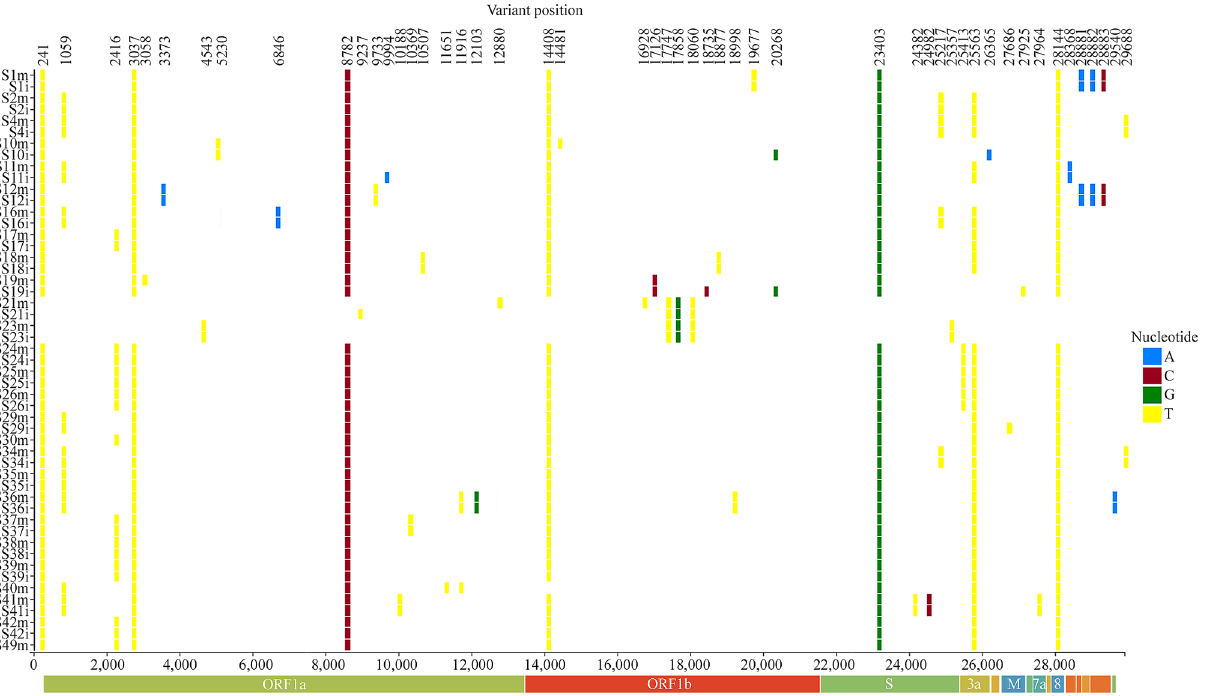
Figure 1. Distribution of polymorphisms in 27 SARS-CoV-2 genome sequences isolated from the early cases of COVID-19 in eastern Ontario. Viral genome sequencing identified forty-six polymorphic sites in twenty-seven viral genomes. S_m refers to the sample sequenced on the MinION and S_i refers to the sample sequenced on the Ion Torrent next generation sequencing